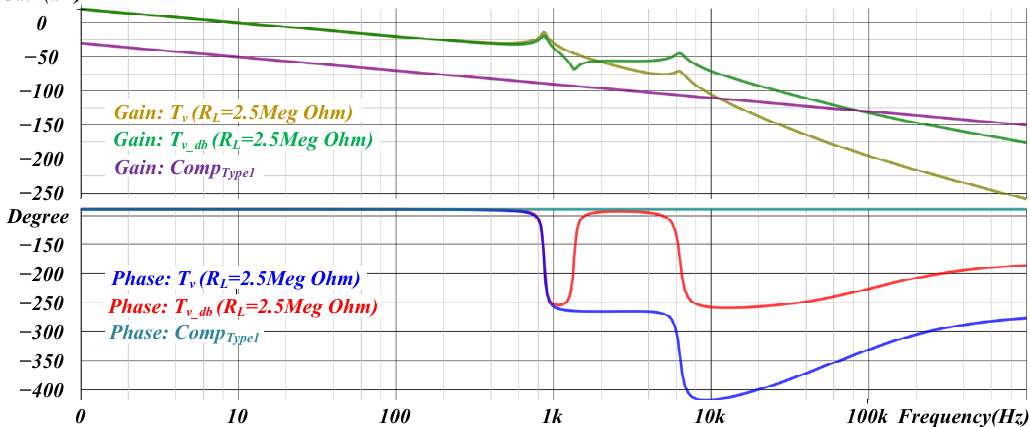
Figure 25. Bode plot of the closed-loop transfer function using the second compensator. Figure 26 compares the simulation results of the system transient response of the first and second compensators. The load resistance is switched from R L = 2.5 Meg Ω to R L = 2.5 Ω when R L is t = 70 mS. When t = 120 mS, the load resistance is switched from R L = 2.5 Ω to 2.5 Meg Ω again. Figure 26 shows that the transient response of the first type of compensator is considerably slow, the boundary limit mode is not triggered, and the system is stable but takes a long time to reach the steady-state. However, the transient response of the second type of compensator has a short recovery time. It triggers the boundary limit mode. Hence, the performance of undershoot and overshoot is better, the output voltage is stabilized for a short time, and the system returns to stability in the general operation mode. Figure 26 shows that with the second type of compensator, the system can eventually return to stability even though T v_db has unstable factors.